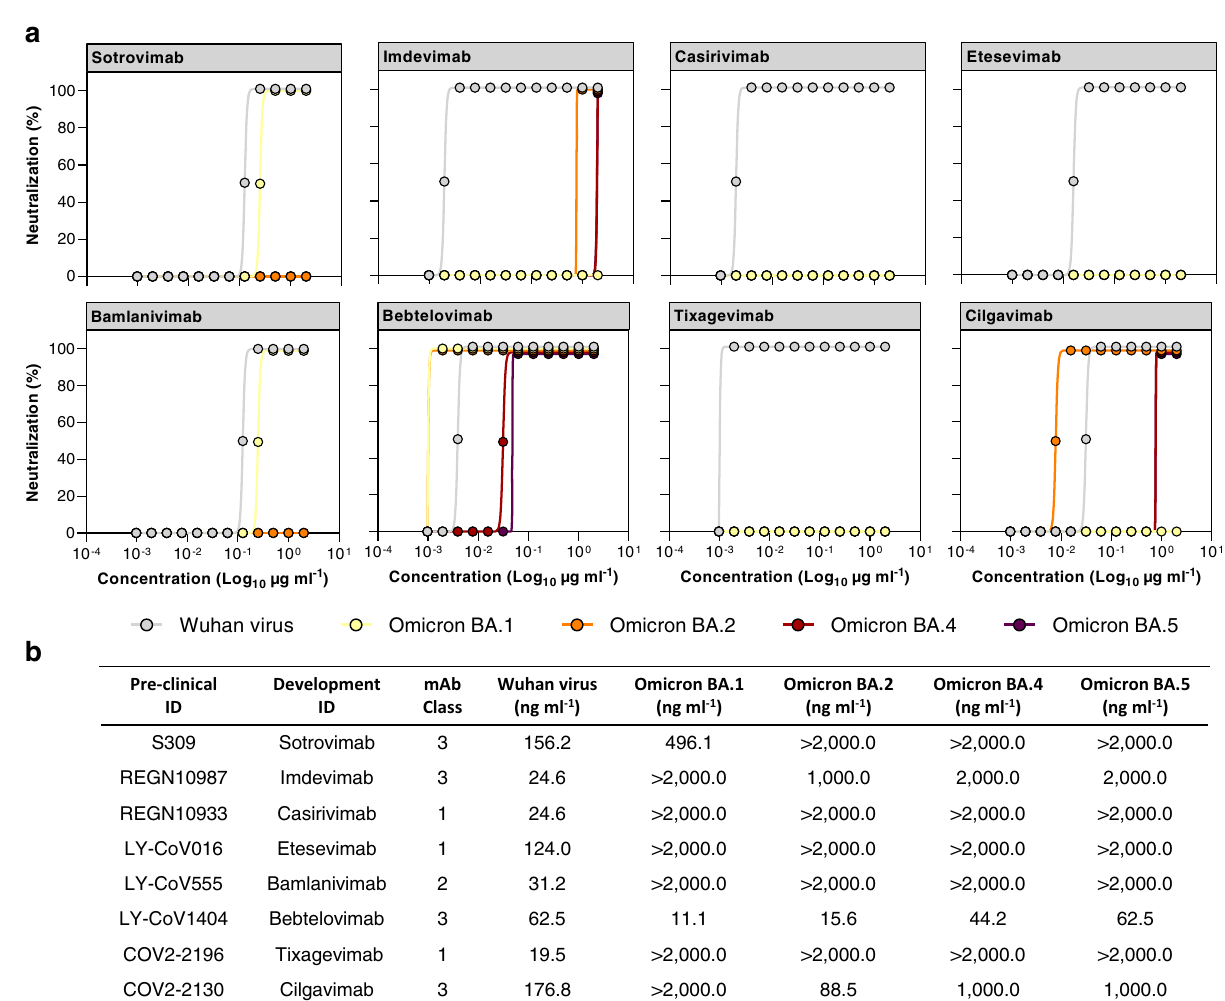
Fig.4|NeutralizationactivityofCOVID-19therapeuticnAbs.a Graphsshowthe CPE-MNneutralizationactivityoftherapeuticnAbsagainsttheoriginalSARS-CoV-2 virus originated in Wuhan and the Omicron BA.1, BA.2, BA.4 and BA.5 variants.